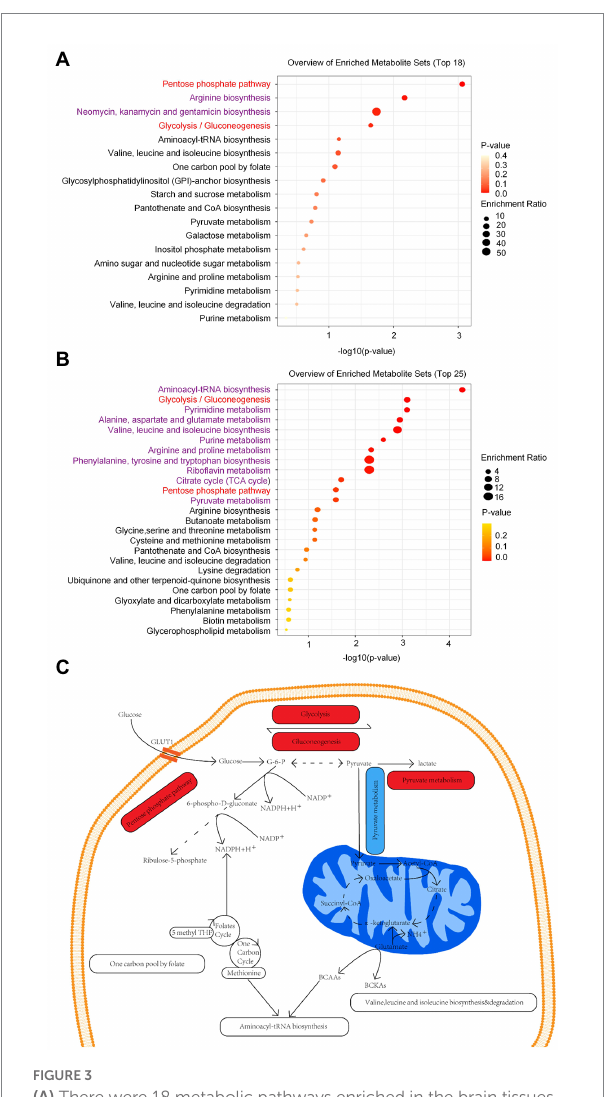
FIGURE 3 (A) There were 18 metabolic pathways enriched in the brain tissues of marmoset monkey, and the top 4 metabolic pathways were significantly enriched. (B) There were 25 metabolic pathways enriched in human serum, and the top 12 metabolic pathways were significantly enriched. The enriched pathways common to marmosets and humans are highlighted in red, and the remainder in purple. (C) Schematic diagram of the common enriched pathways in the neurons of human brain tissue. Activated pathways are shaded in red, inhibited pathways are shaded in blue, and other enriched pathways are shaded in white. G-6-P, Glucose-6-phosphate; BCAAs, Branched-chain amino acids: valine, leucine, and isoleucine; BCKAS, Branched-chain ketone acids; GLUT1, Glucose transporter